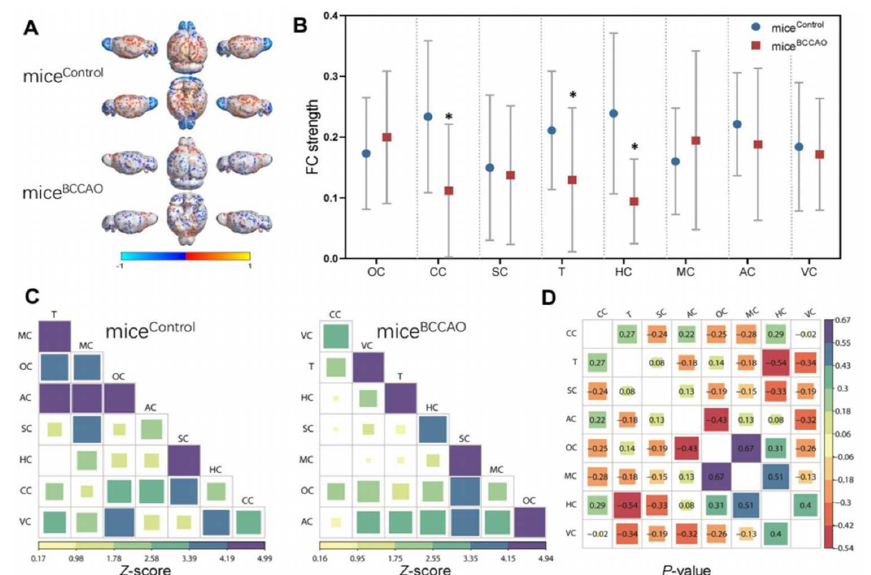
Figure 2. Effect of gut dysbiosis following cerebral ischemic/reperfusion injury on brain structure and function. The eight brain-specific regions, such as the orbitofrontal cortex (OC), somatosensory cortex (SC), cingulate cortex (CC), hippocampus (H), motor cortex (MC), thalamus (T), auditory cortex (AC), and visual cortex (VC), in mice subjected to cerebral ischemic/reperfusion injury induced by occlusion of bilateral carotid common carotid arteries (BCCAO group) or sham-operation (control group). ( A ) The functional connectivity between specific regions of interest of both control and BCCAO groups is shown in the virtual graphics. ( B ) Mean functional connectivity strength in brain network was measured using two-way repeated-measures ANOVA with Tukey multiple comparisons as post hoc test. ( C ) The mean functional connectivity matrices show the strength of functional connectivity between pairs of brain regions in the normal and stroke groups. ( D ) Cor- relation analyses in the regions (8) of interest in animal brain; the colour scale indicates the func- tional connectivity strength. * p < 0.05. The figure is reused as per journal copyright permission [145].